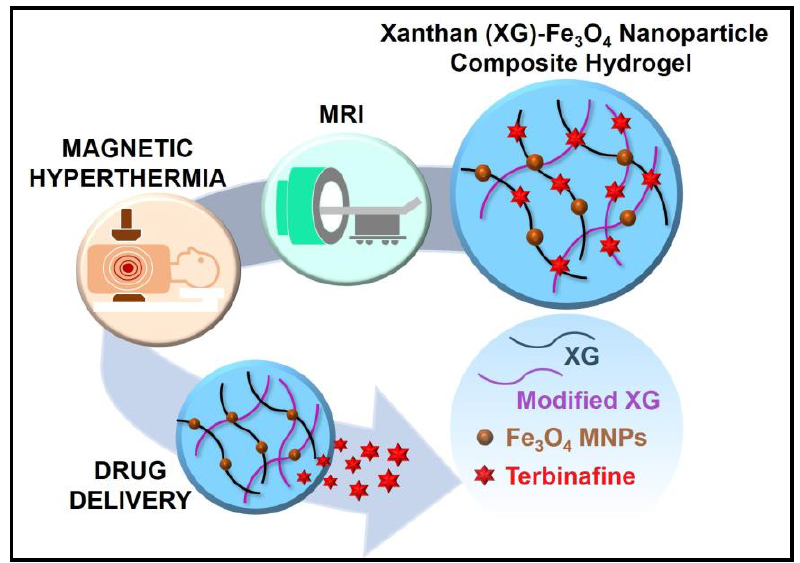
Figure 3. Xanthan gum-Fe 3 O 4 nanoparticle composite hydrogel for the theranostics application [47]. Reproduced from ref [47]. Copyright 2021 American Chemical Society.